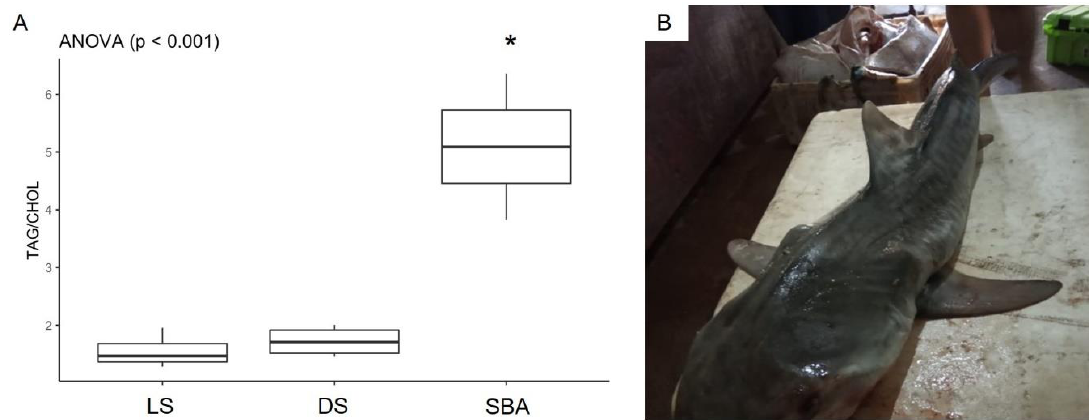
Figure 6. Metabolic markers analyzed in tiger sharks. ( A ) Triglycerides concentrations, ( B ) Total cholesterol concentrations. LS—live sharks, DS—dead sharks, SBA—sharks with bile accumulation. Boxplots respectively represent minimum, first quarter, median, third quarter, and maximum values. Statistical differences are represented by (*).